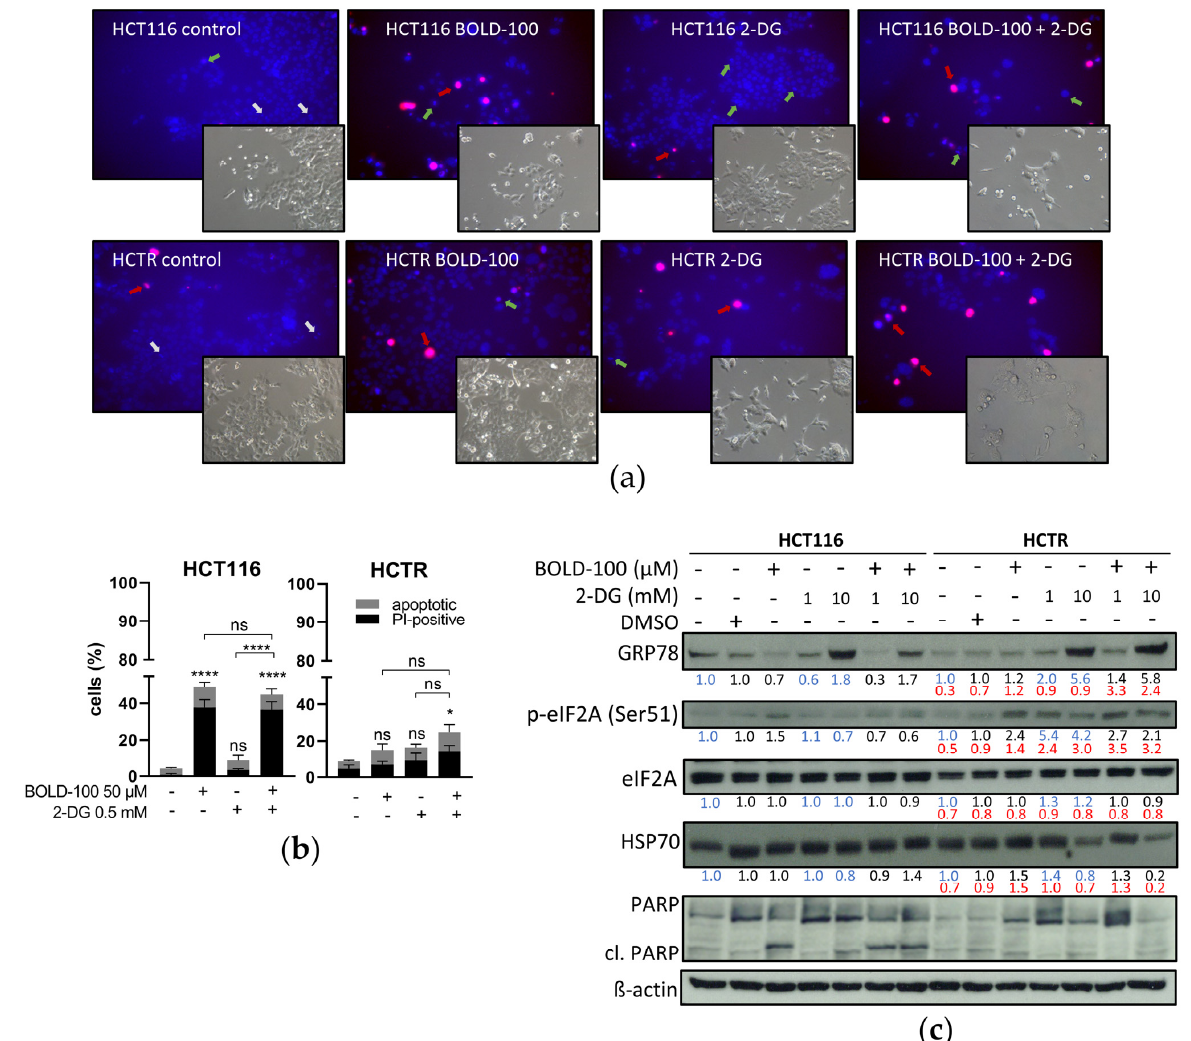
Figure 4. Glucose deprivation by 2-DG differentially regulates ER stress and leads to apoptotic cell death upon combination with BOLD-100. ( a ) Representative composite images show morphological changes of HCT116 or HCTR cells detected with dual staining of Hoechst 33342/PI. Cells were treated for 72 h with DMSO (control, equivalent to BOLD-100), 2.5 mM 2-DG, 100 µM BOLD-100 or their combination and imaged by fluorescence microscopy (magnification 20×). Grey arrows indicate examples of mitotic nuclei. Green arrows indicate live cells with apoptotic nuclei. Red arrows indicate dead cells with late apoptotic nuclei. ( b ) Quantification of treatment-respective early and late apoptotic nuclei depicted in ( a ). Statistical significance of differences was calculated using a two-way ANOVA with Tukey´s multiple comparisons test: * p < 0.05, **** p < 0.0001; ns: non- significant. ( c ) Expression levels of GRP78, peIF2A (Ser51), eIF2A, HSP70, and PARP after 24 h of treatment of HCT116 and HCTR cells with the indicated concentrations of BOLD-100, 2-DG, or their combination, analyzed by Western blotting. Two different control states were included, i.e., medium control without DMSO for 2-DG and with DMSO as a solvent control for BOLD-100. β -actin served as the loading control. The numbers below indicate quantified Western blot signal intensities normalized to their respective controls: blue, medium; black, DMSO; and red, HCTR vs. HCT116 cells. 3.4. HCT116 and HCTR Cells Differ in ER Stress Response to 2-DG and BOLD-100 Treatment